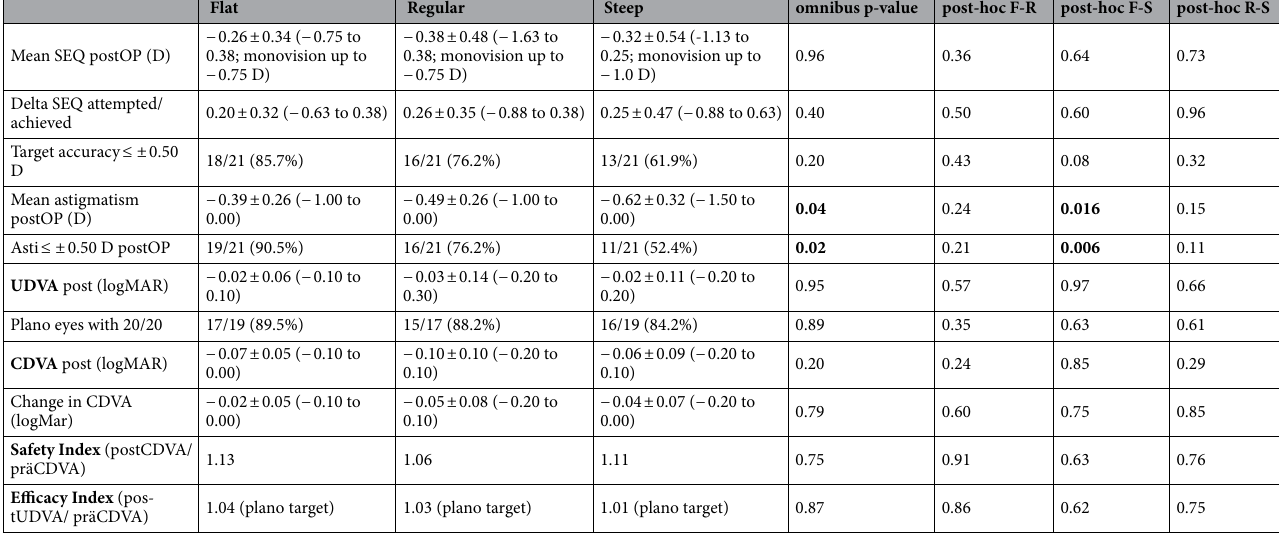
Table 2. Surgical outcomes of SMILE.